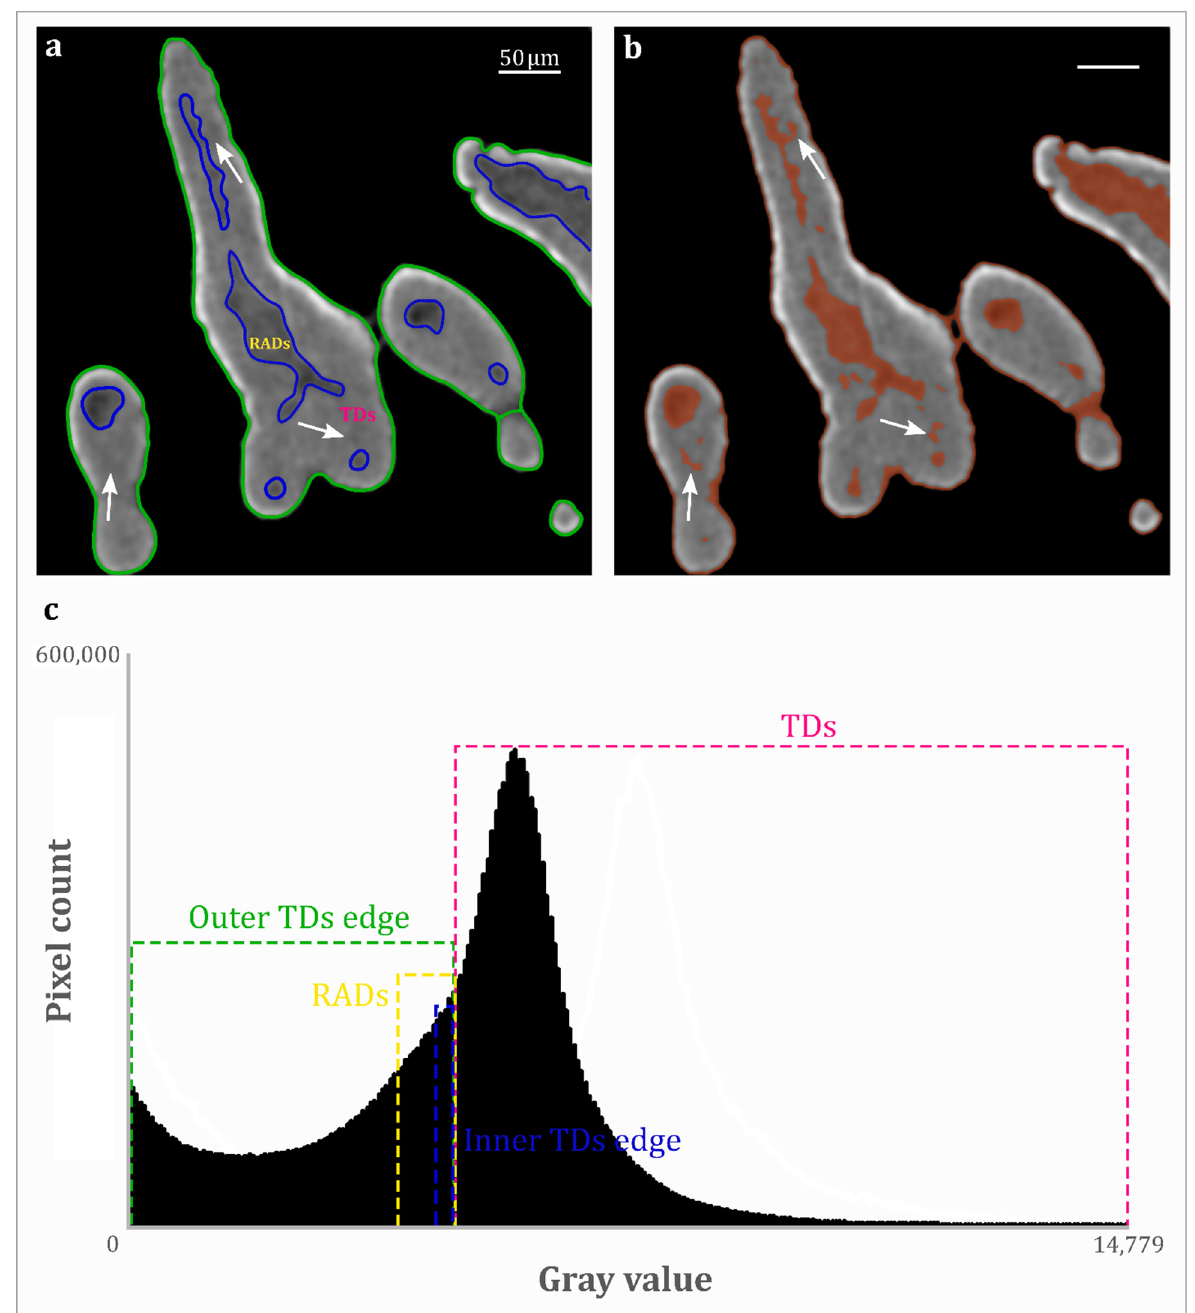
Figure 5. Slices and typical histogram of gray-values in PCE image and quality of non-DL-based image segmentation. ( a ) Close-up of the skeleton, showing RADs (dark gray areas), TDs (light gray areas), and delineating the outer and inner edges of TDs (green and pink lines, respectively). ( b ) Result of a simple threshold applied to segment RADs (RADs segmented by the thresholding method are colored in red). Note that, compared to their actual shape in the ground truth image ( a ), RADs are not precisely segmented (see arrows for example mismatch, where TDs regions are classified as RADs) and they are not distinguished from the outer edge of TDs, which are also thresholded as RADs by this method. ( c ) Gray-value histogram for an example tomographic stack of an imaged coral skeleton. The gray-value ranges for all regions depicted in ( a ) are highlighted in different colors. Note the overlap between the gray-value ranges of RADs and of the inner/outer edges of TDs, which makes it impossible to reliably segment these regions by simple threshold, as demonstrated in ( b ).